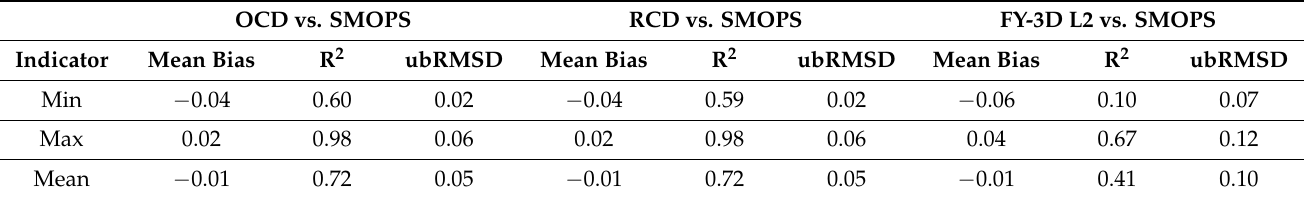
Figure 8. Validation of soil moisture retrieved using OCD (green line), RCD (red line) and FY-3D L2 (blue line) based on SMOPS products. Table 1. Summary of the average validation indicators of soil moisture retrieval SMOPS